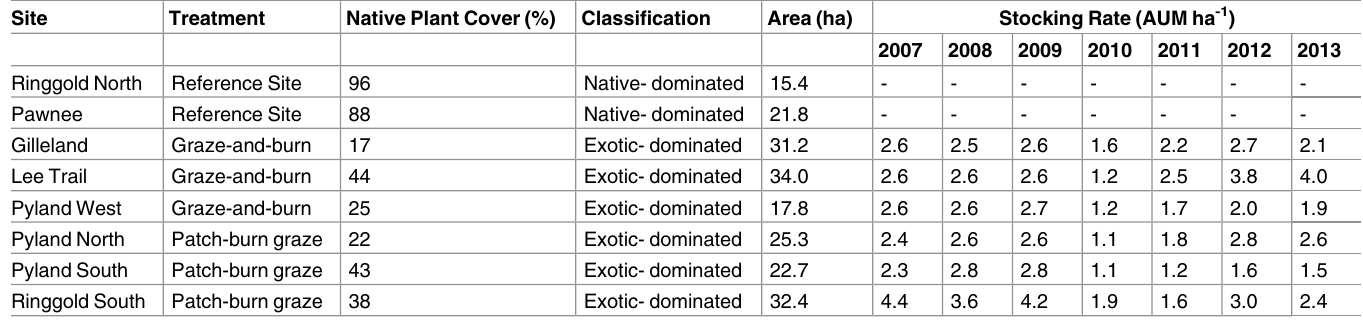
Table 1. Sites used in this study. Classificationinto native- and exotic-dominated was based on the proportion of native plant cover in 2007, the first year of the experiment. Reference sites were native-dominated tallgrass prairies that were not grazed in this study but burned in their entirety on a three year rota- tion. Referencesites were not treatments per se, rather they were used to comparehow the two grazingtreatments differed from remnant, native-dominated, tallgrass prairies. See methods for explanation of the two grazingtreatment types. Stocking rate is in Animal Unit Months per hectare (AUM ha -1 ). Site Treatment Native Plant Cover (%)